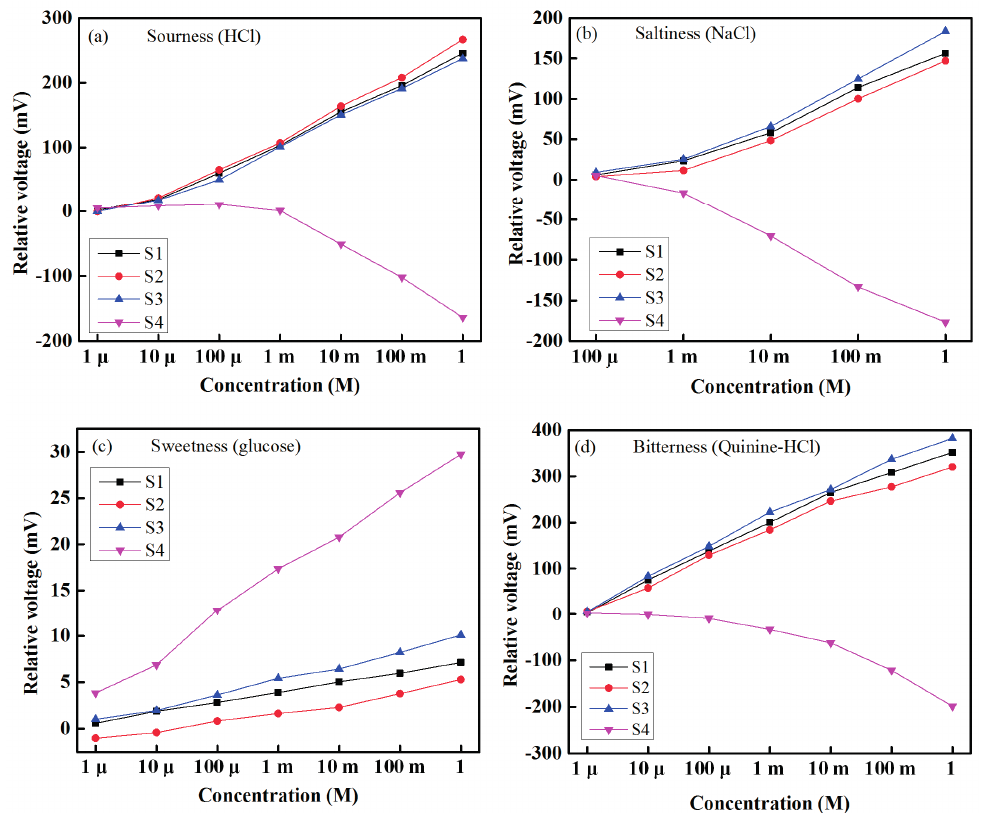
Figure 9. Responses of the sensing elements of the array with respect to type of taste and degree of concentration: ( a ) sourness (HCl); ( b ) saltiness (NaCl); ( c ) sweetness (glucose); and ( d ) bitterness